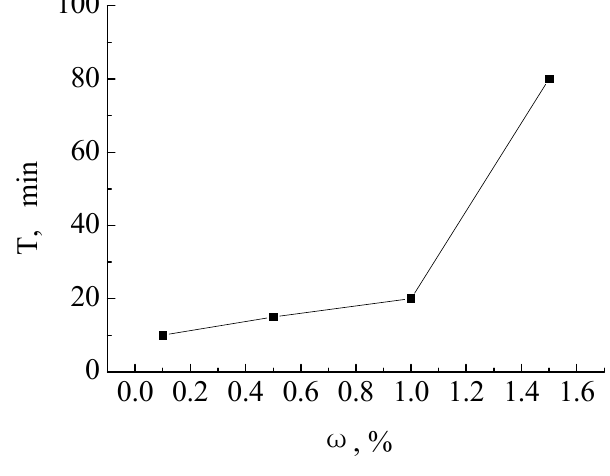
Figure 2. Emulsifying properities of lacquer wax gemini